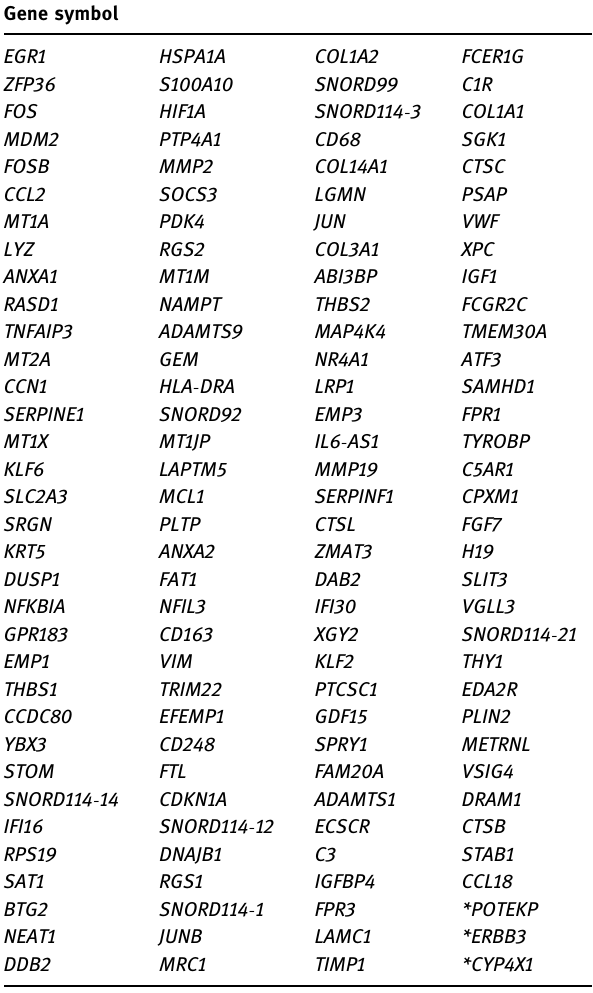
Table A1: The list of the radiation - associated genes in breast cancer ( BCa ) in the GSE65505